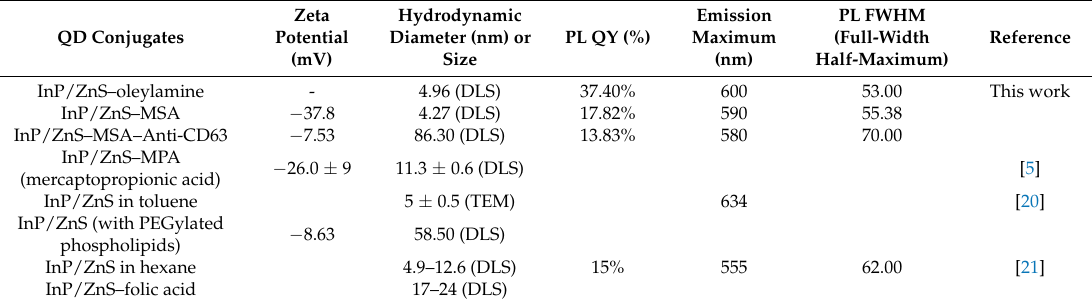
Table 1. Summary table of the physical properties of the QDs. DLS: dynamic light scattering, MSA: mercaptosuccinic acid, PL QY: photoluminescence quantum yield.